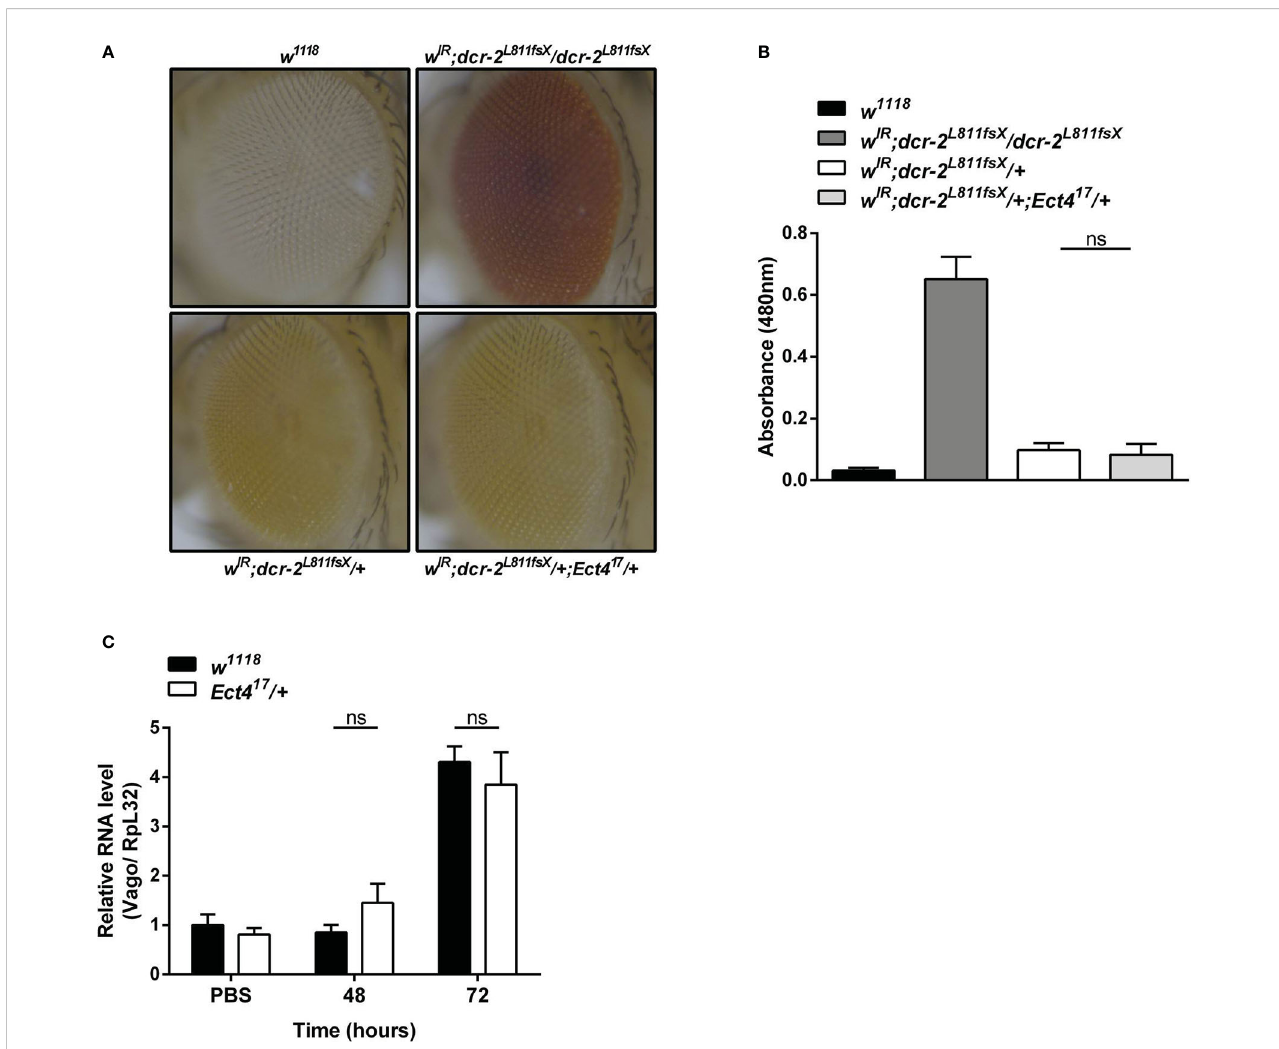
FIGURE 3 Ect4 de fi ciency did not affect siRNA-mediated gene silencing. (A) Effects of altering dosages of Ect4 in w IR ; dcr-2 L811fsX background. The eye color of a white null mutant fl y (upper left panel) and a white + fl y carrying GMR>UAS-wIR transgene and homozygous mutant for dcr-2 L811fsX (upper right panel). The eye color of a fl y carrying heterozygous dcr-2 L811fsX mutation with (bottom right panel) or without (bottom left panel) one Ect4 mutant allele. (B) Red-eye pigment levels of the indicated phenotype were determined by measuring absorbance at a wavelength of 480 nm (n = 50 for each group). (C) Expression levels of Vago at 48 and 72 h post-infection in wild-type or Ect4 mutant fl ies challenged with DCV. Data represent the means ± standard errors of 3 independent pools of 50 female fl ies (B) or 10 male fl ies (C) for each genotype. The t -test (B, C) : ns, not signi fi